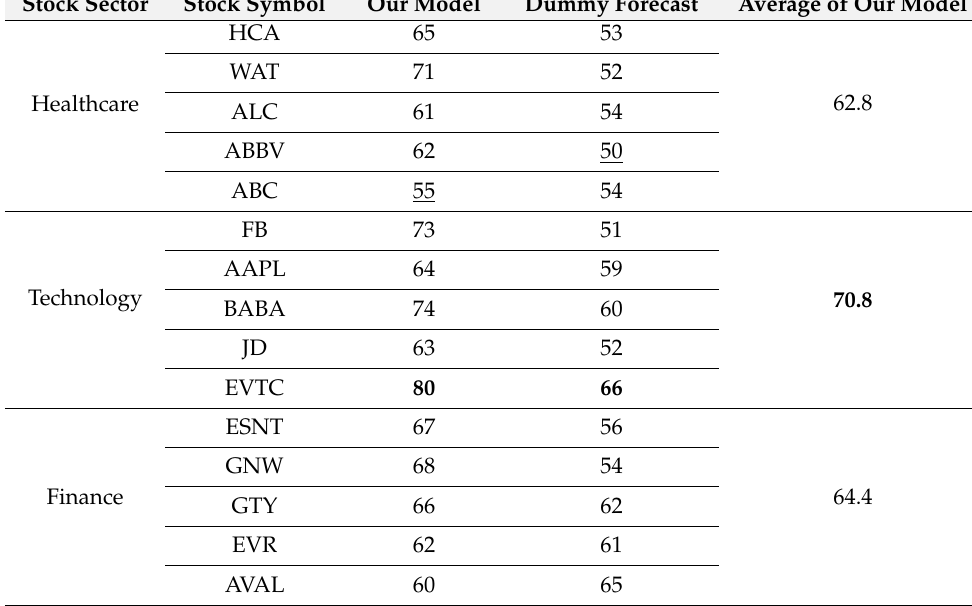
Table 11. Accuracy of our forecasting model. Stock Sector Stock